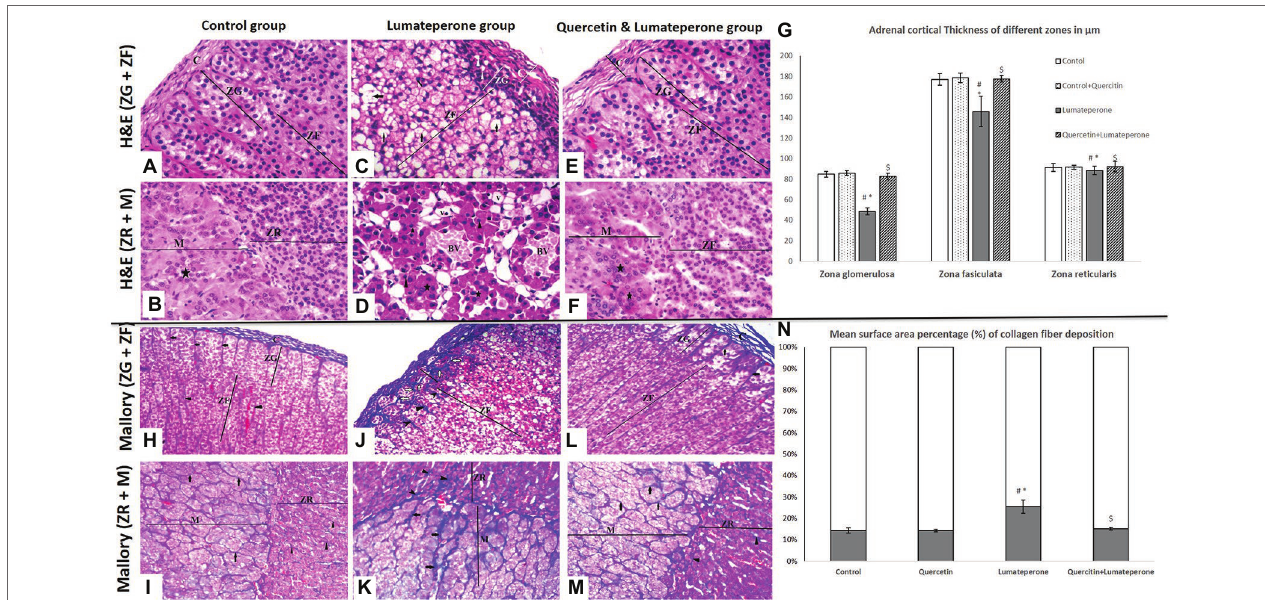
FIGURE 4 | Adrenal Histopathology using hematoxylin and eosin (H&E×200) and Mallory trichrome (×200) staining. (A) A section of group I (control group) showing part of the adrenal cortex surrounded by a tissue capsule. Under the capsule, zona glomerulosa (ZG) cells are clustered. The next wider zone is zona fasciculata (ZF), with regular cell arrangement and foamy cytoplasm (H&E×200). (B) A section of group I (control group) showing part of the adrenal cortex, zona reticularis (ZR), contains eosinophilic cells arranged in cords near the adrenal medulla with chromaffin cells arranged in clusters (star; H&E×200). (C) A section of group III (lumateperone) adrenal cortex segments showing disorganized zona glomerulosa (ZG) cells with numerous intercellular spaces (arrowhead) and multiple deeply stained nuclei. Zona fasciculata cells (ZF) appeared separately disorganized, exhibit swollen, vacuolated cytoplasm (arrow), and several deeply stained nuclei. Note the apparent thick capsule (H&E×200). (D) A section of a group III (lumateperone) segment of the adrenal medulla with chromaffin cells arranged in clusters (star) with darkly stained small pyknotic nuclei (arrowhead). Note widening between medulla cells and congested blood sinusoids (BV; H&E×200). (E) Group IV (quercetin + lumateperone) section showing part of the adrenal cortex surrounded by a capsule of the connective tissue. Regular glomerulosa (ZG) and fasciculate zone (ZF) (H&E×200). (F) Group IV (quercetin + lumateperone) showing zone reticularis (ZR) has a typical normal appearance near the adrenal medulla with chromaffin cells in clusters (arrowhead; H&E×200). (G) Adrenal cortical thickness of different layer among groups. (H) Adrenal cortex of group I (control) showing usual regular capsule collagen fibers with regular fibers in extending trabeculae between ZG cells (short arrows) and zona fasciculata (arrowhead; Mallory’s trichrome×200). (I) A section of the adrenal gland group I (control group) showing part of the adrenal cortex, zone reticularis (ZR) with thin collagen fibers separating cells (arrowheads) near the adrenal medulla with thin collagen fibers separating chromaffin cell clusters (arrow; Mallory’s trichrome ×200). (J) Adrenal cortex